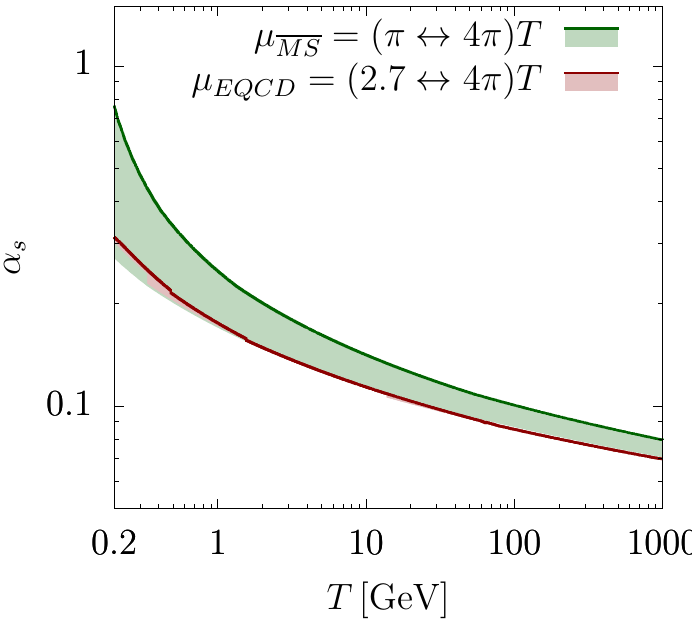
Figure 8 . The di(cid:11)erent choices for the coupling as a function of the temperature adopted in this work. The green band (and bounding line) is obtained from a two-loop QCD MS running with one-loop threshold matching (and hence is continuous at the thresholds) with (cid:22) The green bounding line is for the smallest scale (cid:22) bounding line are obtained from the EQCD e(cid:11)ective coupling with (cid:22) EQCD = (2 : 7 which is discontinuous at the quark